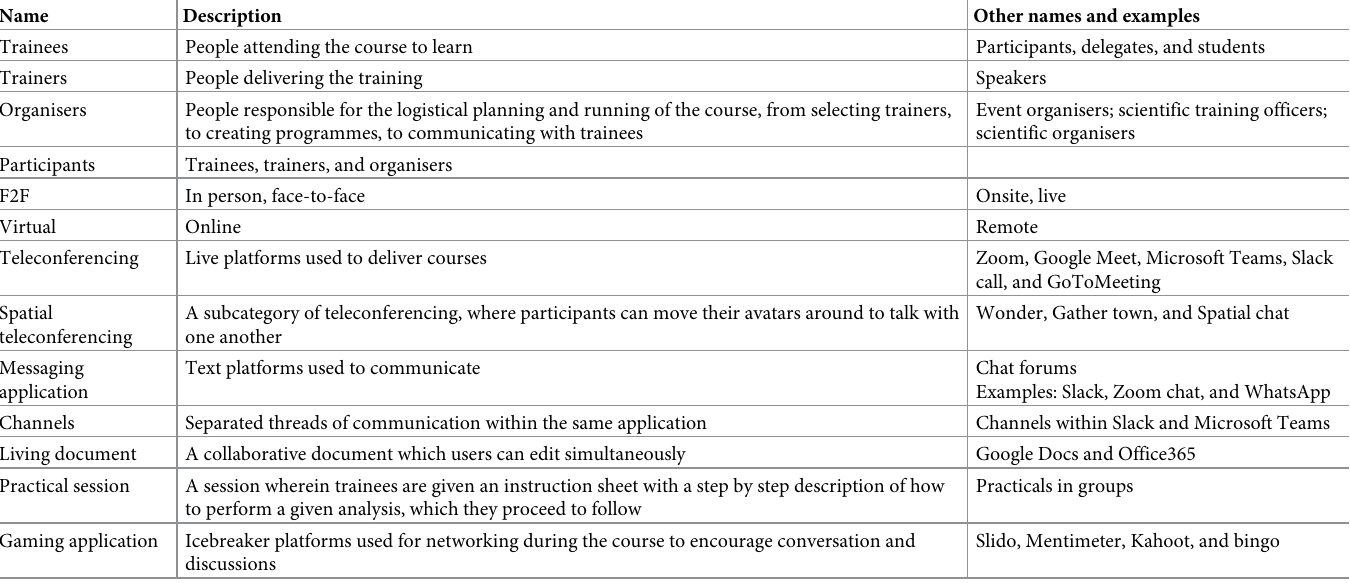
Table 1. Summary of the commonly used terminology in course organisation used to distinguish participation, sessions, and